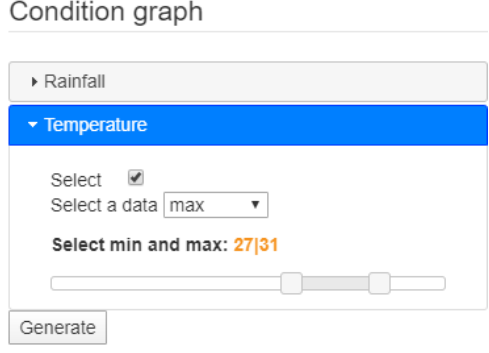
Figure 10. Panel of climate-condition